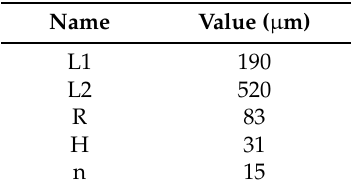
Table 3. The parameter of the